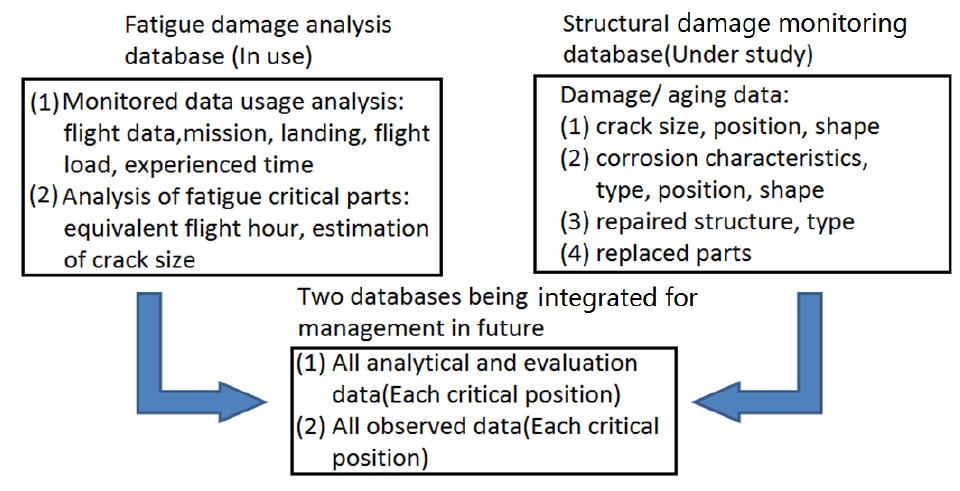
Figure 1. US air force aircraft management schematic [3].